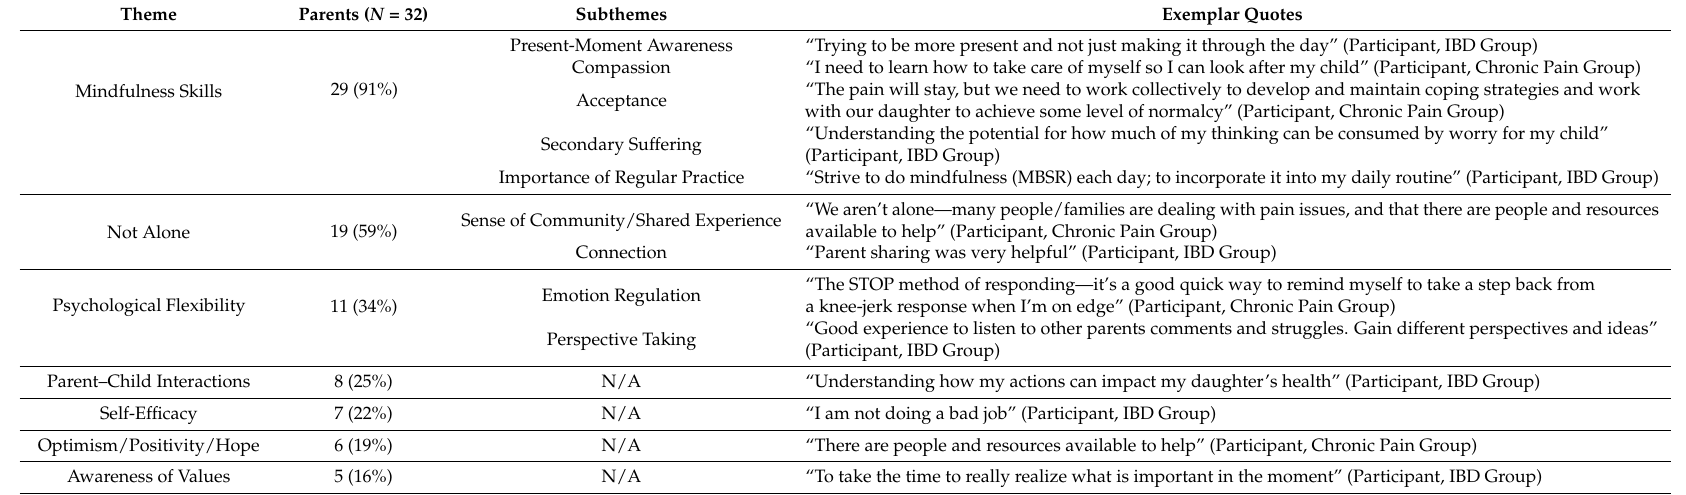
Table 3. Major Themes from the Post Session Questionnaire. MBSR: mindfulness-based stress reduction, STOP: Stop, Take a breath, Observe,